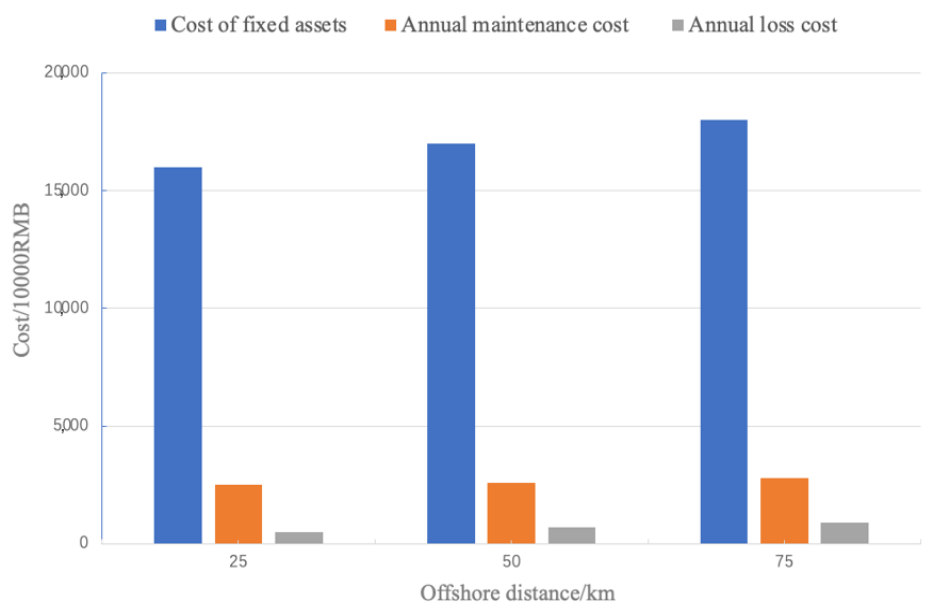
Figure 5. Cost composition of onshore hydrogen production from offshore wind power via DC transmission.